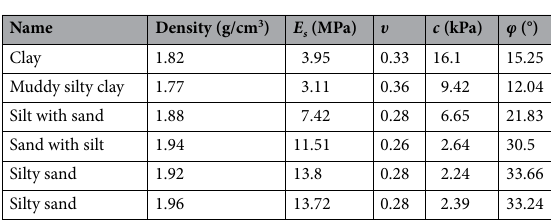
Table 1. Soil layer parameters.